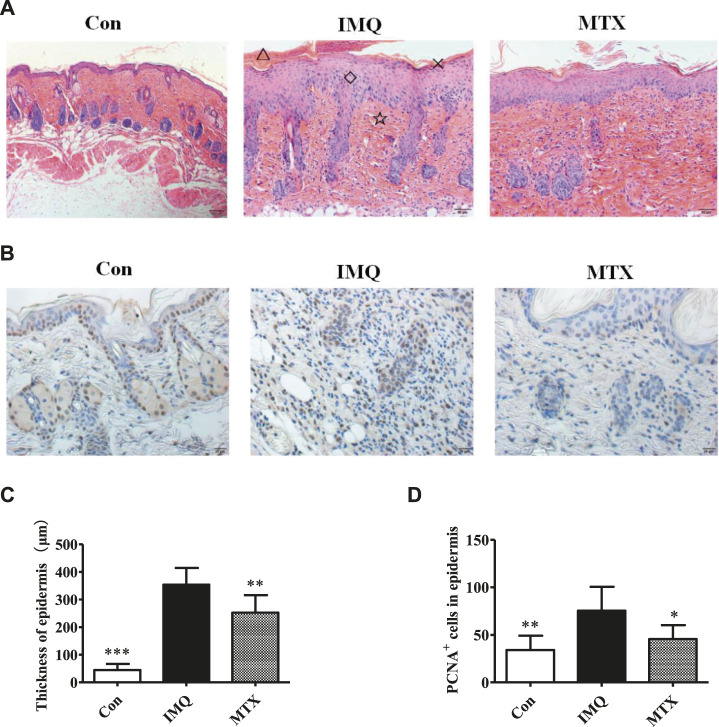
The histological analyses (H&E staining, ×200) of skin lesions and epidermal thickness. △: microlimb swelling; ×: parakeratosis; ◇: acanthosis; ☆: lymphocyte infiltration (A); IHC staining (×200) for proliferating cell nuclear antigen (PCNA) (brown) in mouse back skin (B); epidermal thickness of each group (C); statistical analysis of the number of PCNA+ cells in the epidermis of each group (D). Data were expressed as mean ± SD (n = 8). *p < 0.05, **p < 0.01, and ***p < 0.001, vs. IMQ group.